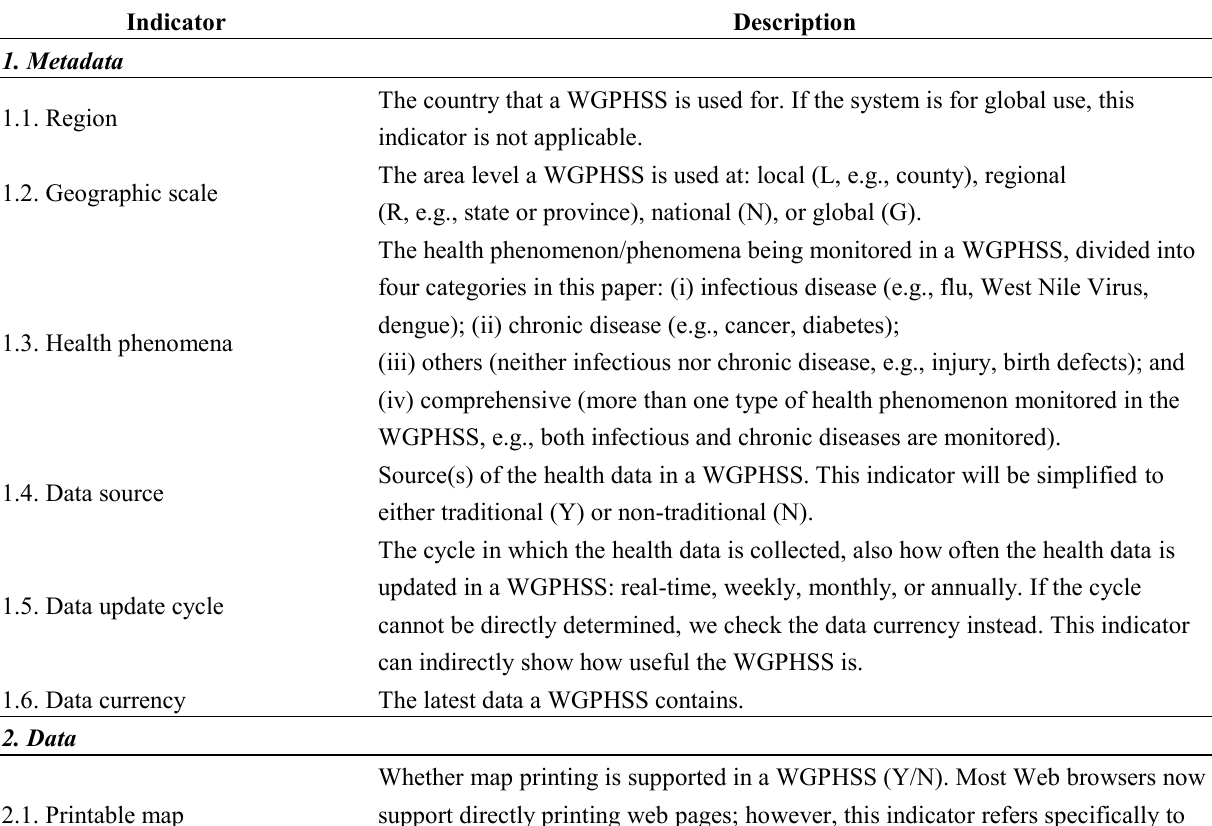
Table 1. Indicators for analyzing Web GIS-based Public Health Surveillance Systems